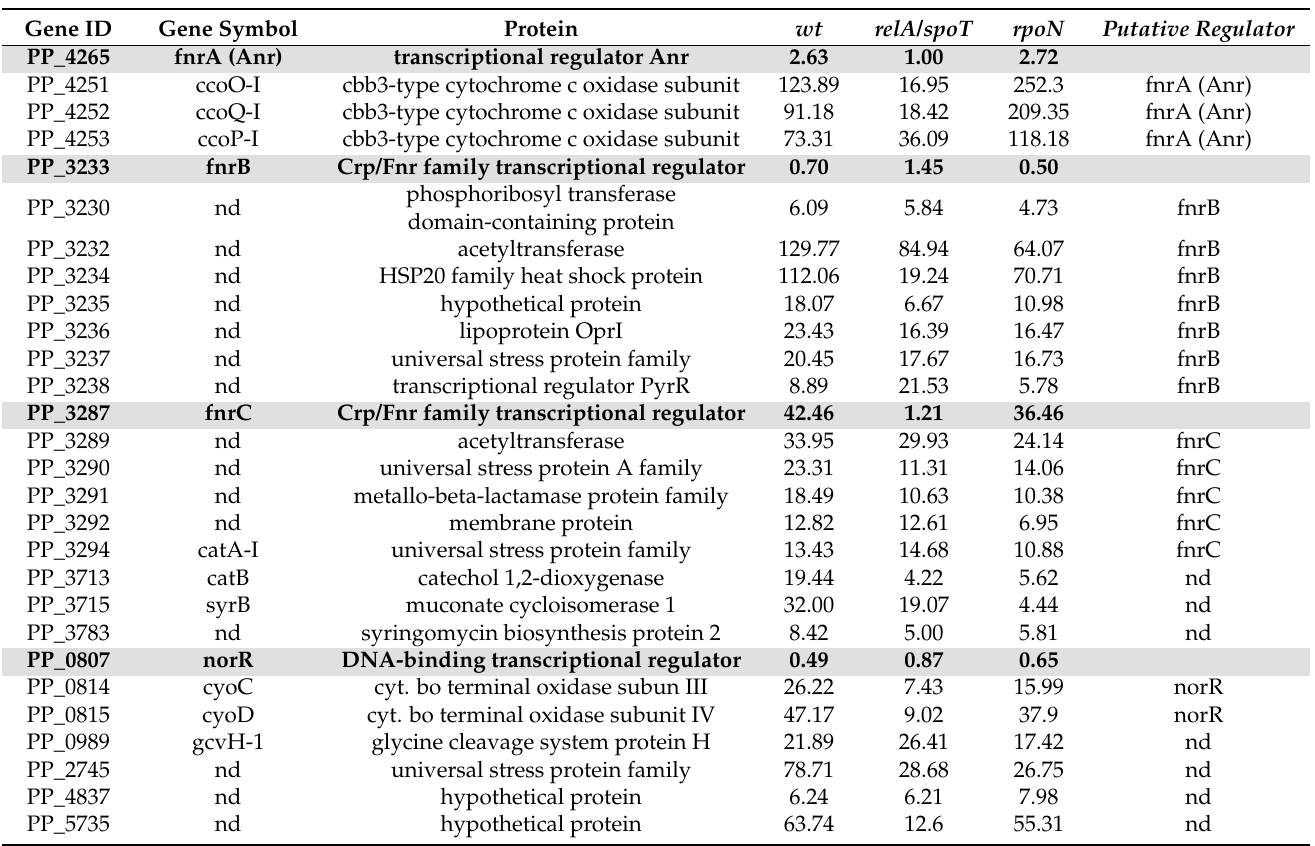
Table 1. List of genes showing statistically significant downregulation detected in all analyzed strains as a result of nitrogen limitation. The values of fold change are given below strain names. wt — P. putida KT2440, relA / spoT — P. putida KT2440 relA / spoT mutant, rpoN — P. putida KT2440 rpoN mutant. The putative regulators of genes showing statistically significant differences in expression are given in grey fields. nd—not